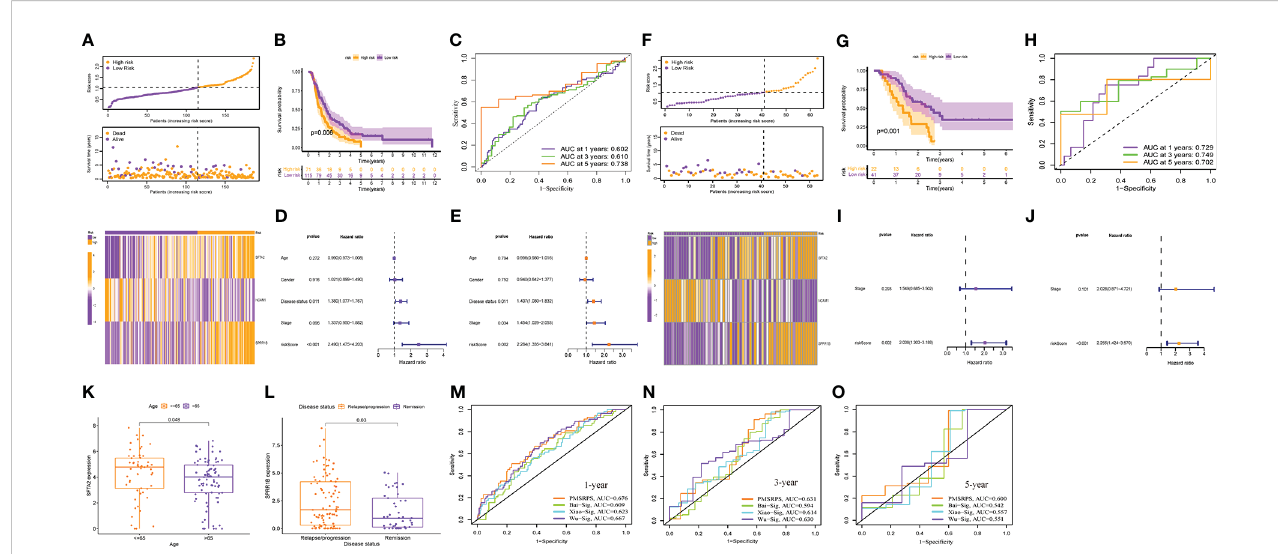
FIGURE 7 External cohort validation of the predicted performance of PMSRPS and performance comparison. (A, F) Risk grouping, survival status, and risk heatmap between the high- and low-risk groups in the ICGC (A) and GSE57495 (F) cohorts. (B, G) Comparison of OS between the high- and low-risk groups in the ICGC (B) and GSE57495 (G) cohorts. (C, H) Time-dependent ROC curves of PMSRPS in the ICGC (C) and GSE57495 (H) cohorts. (D, E, I, J) Results of independent prognostic analysis of PMSRPS in the ICGC (D, E) and GSE57495 (I, J) cohorts. (K, L) Results of external clinical correlation analysis for the high- and low-risk groups in the ICGC cohort. (M – O) Comparison of the performance of PMSRPS with Bai-Sig, Xiao-Sig and Wu-Sig in predicting 1- (M) , 3- (N) , 5-year (O) OS in patients with